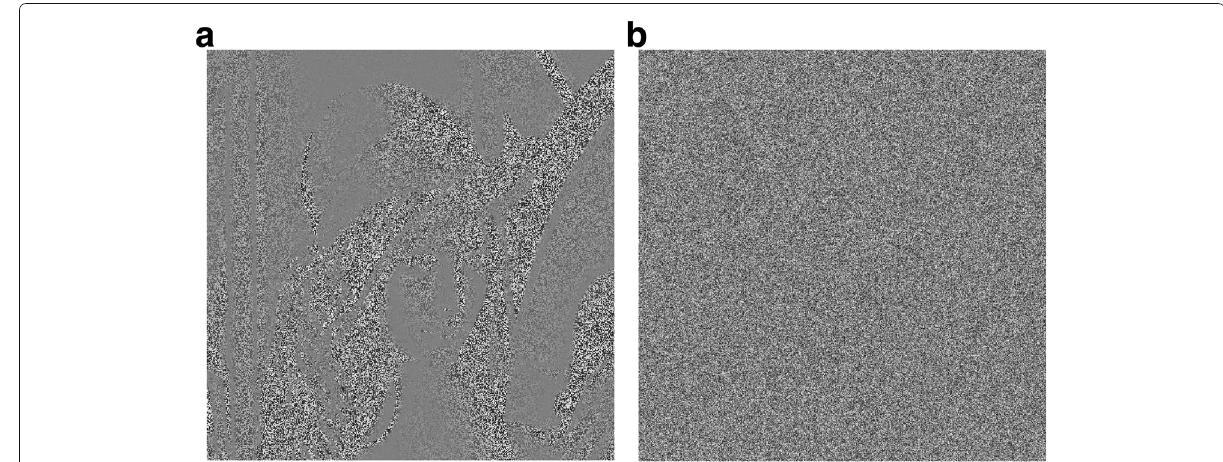
Fig. 2 Encrypting the marked Lena image in the spatial domain. a Sign bit encryption. b Permutation